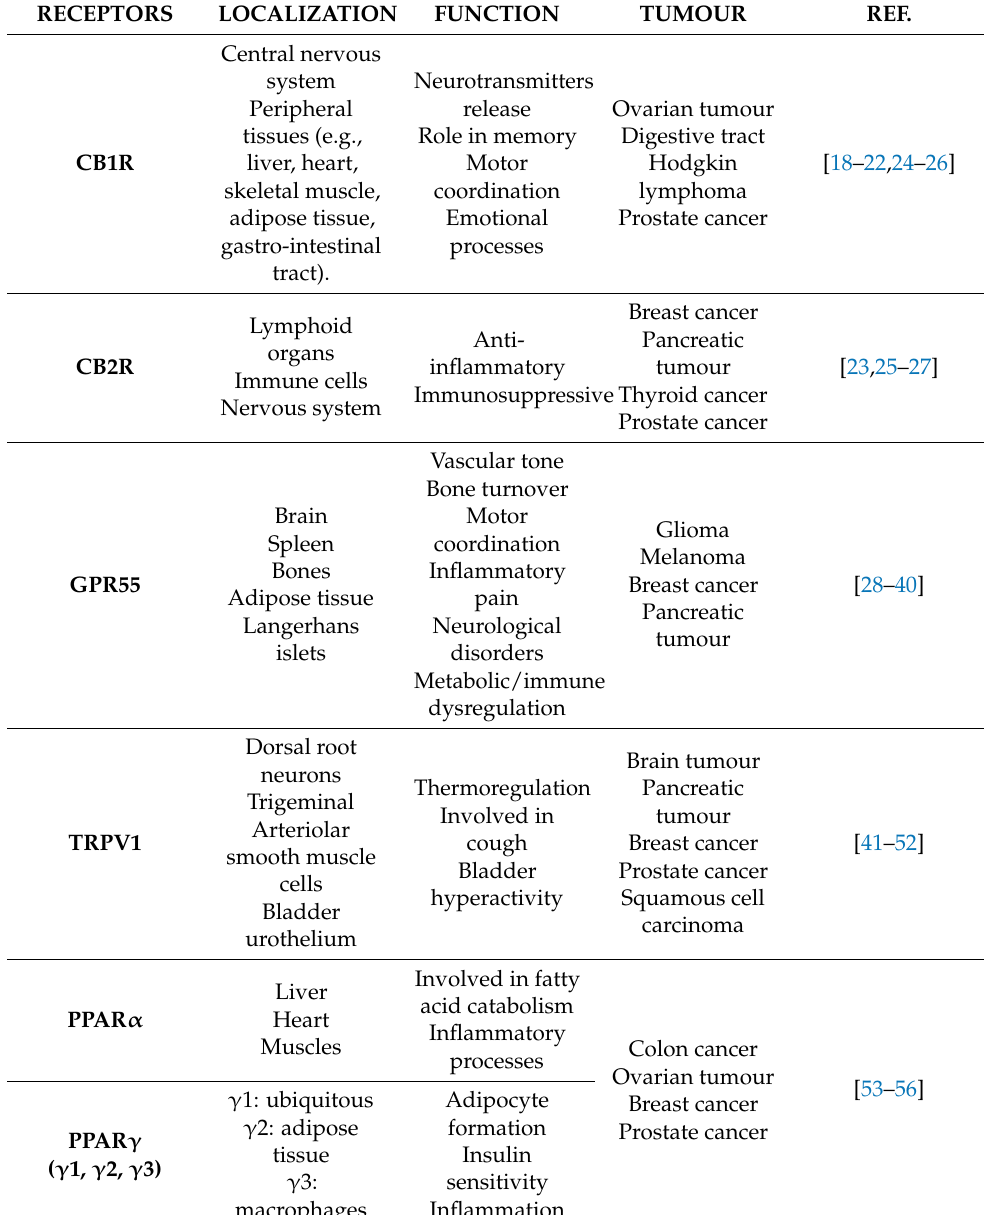
Table 1. Cannabinoid receptors localisation in human organs, function-related and expression in different tumour